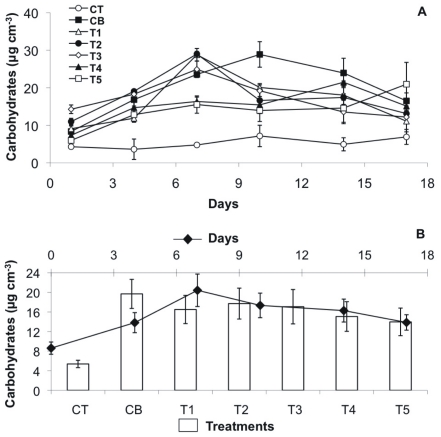
EPS carbohydrate concentrations over the course of the experiment.(A) Mean values (n = 4 per treatment, based on n = 3 replicates per box) with SE of the different treatments over time: positive control CB (black squares), negative control CT (white circles), T1 (TCS: 2 µg/L, white triangles), T2 (TCS: 10 µg/L, black circles), T3 (TCS: 20 µg/L, white diamonds), T4 (TCS: 50 µg/L, black triangle), T5 (TCS: 100 µg/L, white squares). (B) Mean values with SE per day (n = 7, black diamonds) and per treatment (n = 6, bar plots).